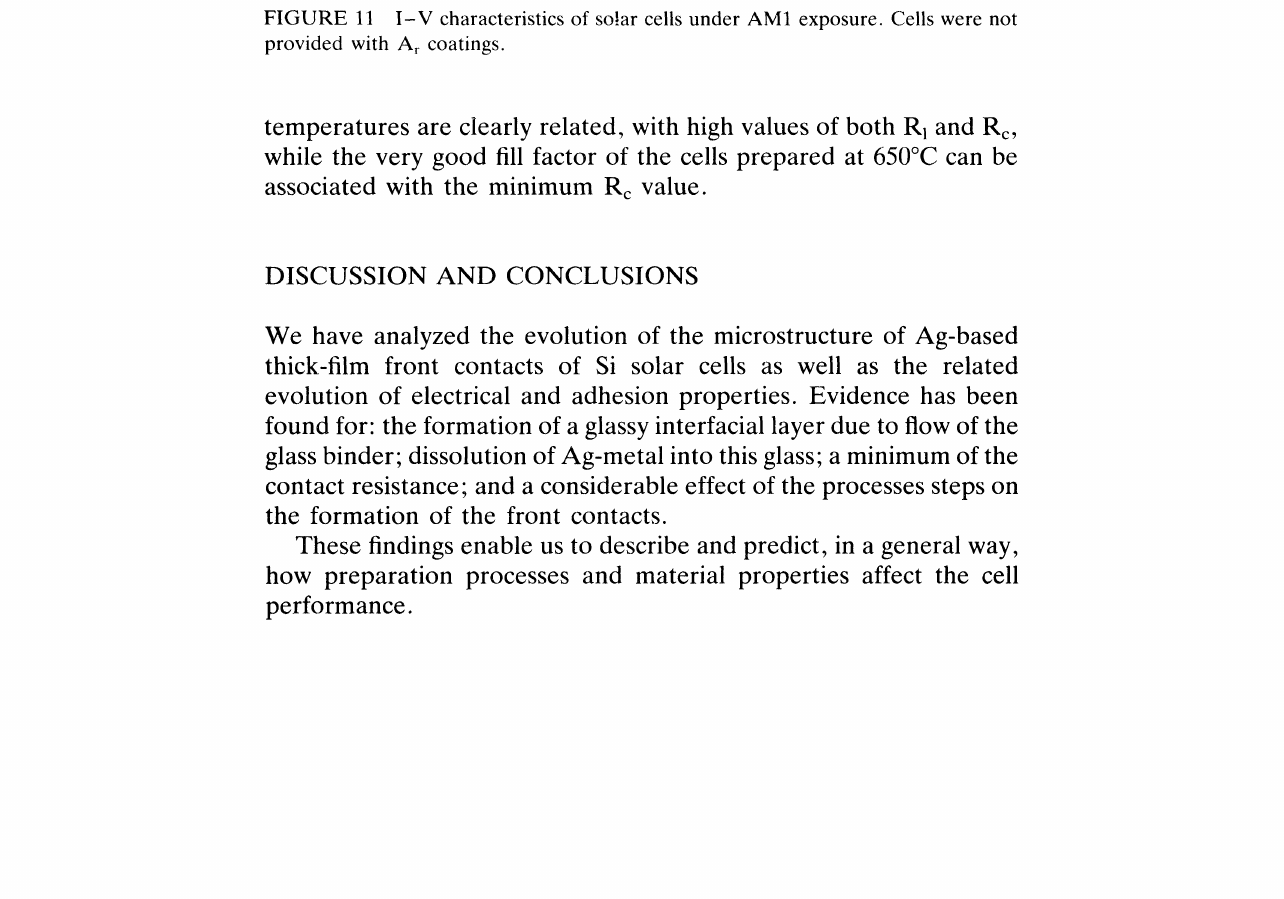
FIGURE 11 I-V characteristics of solar cells under AM1 exposure. Cells were not provided with Ar